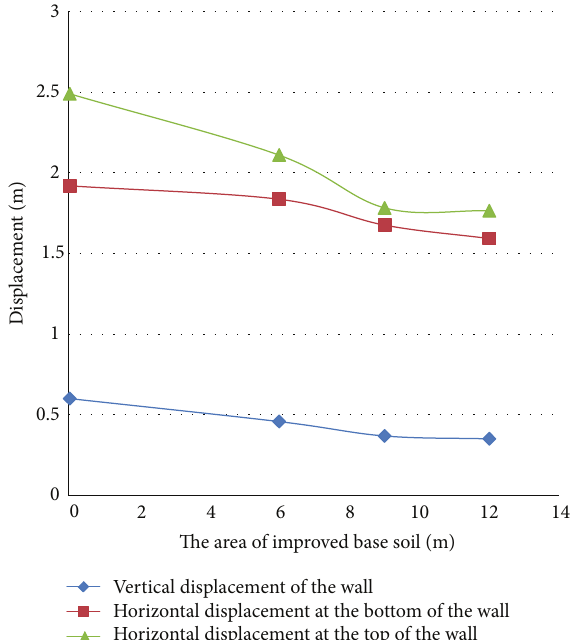
Vertical displacement of the wall Horizontal displacement at the bottom of the wall Horizontal displacement at the top of the wall Figure 11: Horizontal and vertical displacements of the quay wall in different soil improvement areas under the wall.